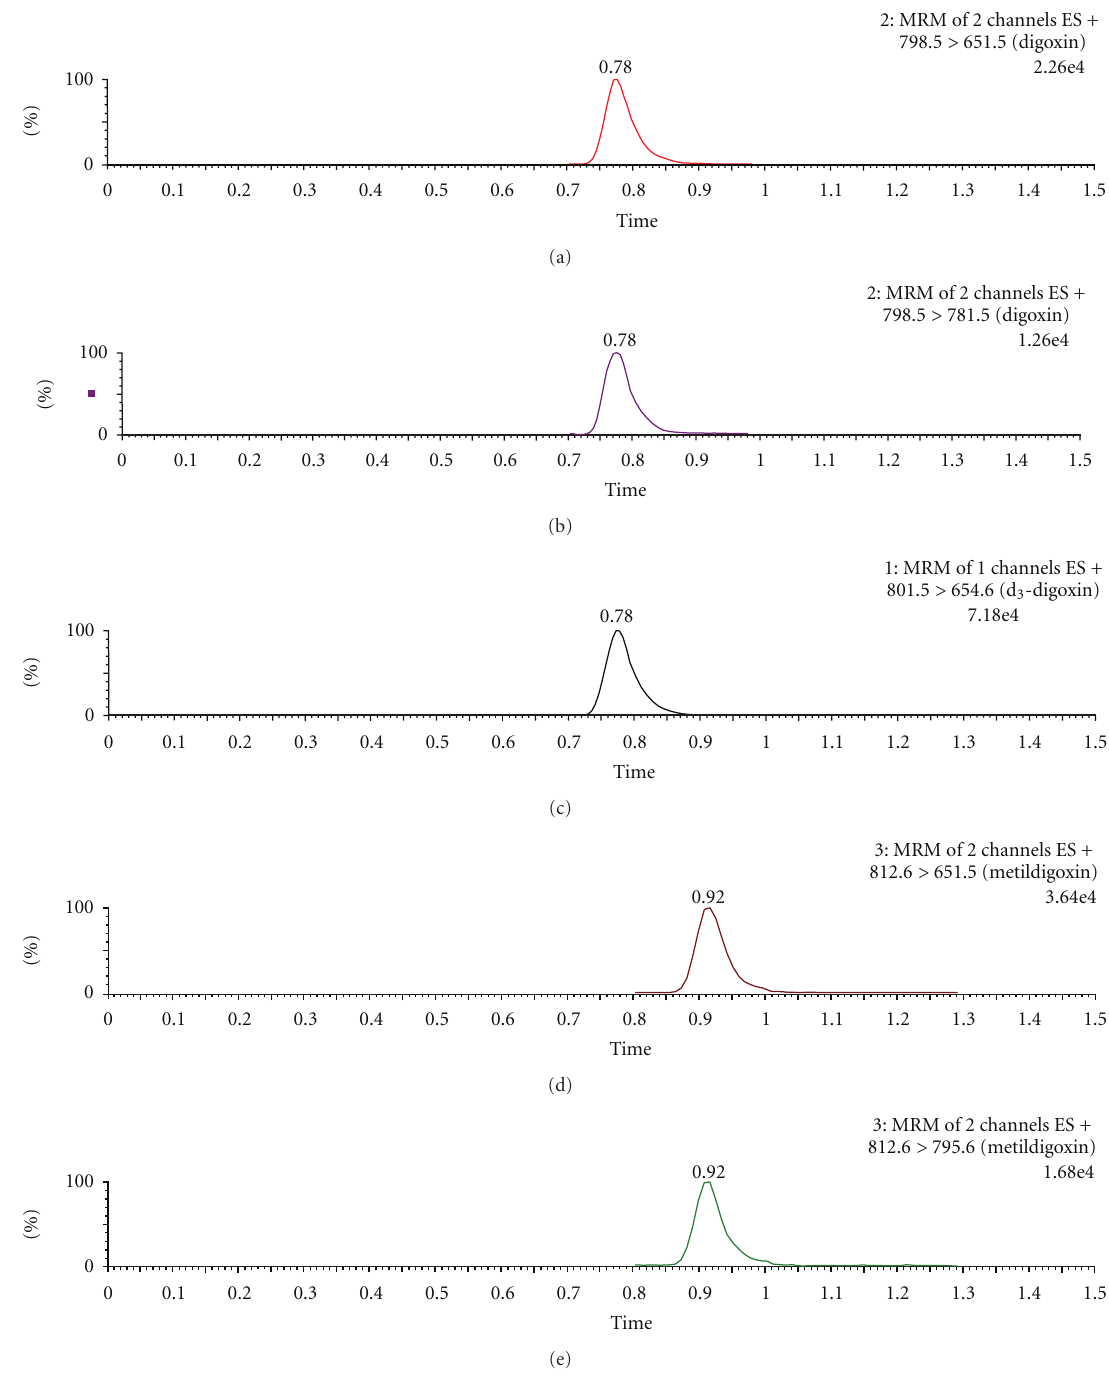
Figure 3: MRM chromatograms of whole blood samples spiked with 1ng/mL of digoxin [(a) and (b)] and metildigoxin [(d) and (e)]; and with 5ng/mL of d 3 -digoxin, internal standard